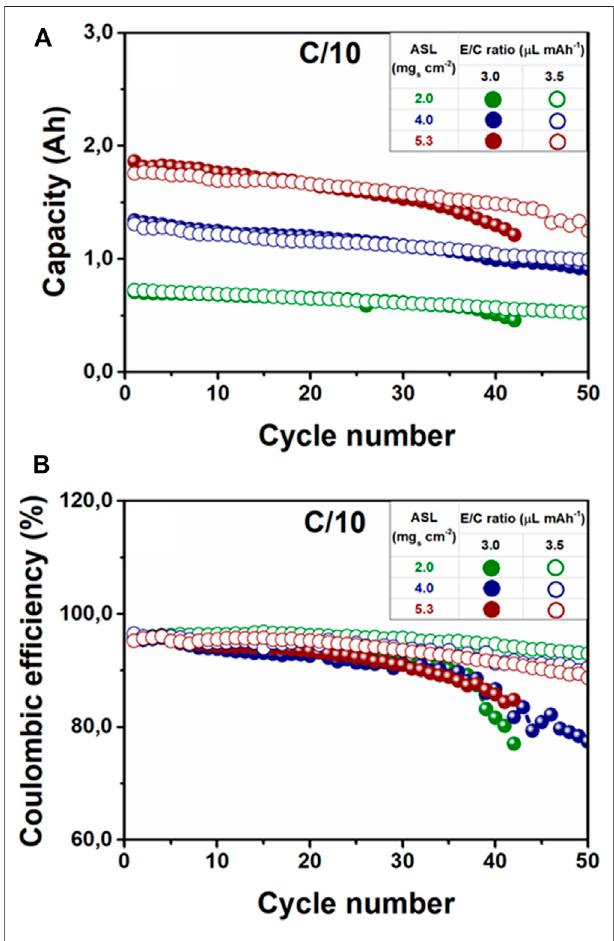
FIGURE 7 | (A) Galvanostatic long cycling performance and (B) Coulombic ef fi ciency of Li-S batteries with different ASL (2.0, 4.0, and 5.3 mg s cm − 2 ) and different E/C ratios (3.0 and 3.5 µl mAh − 1